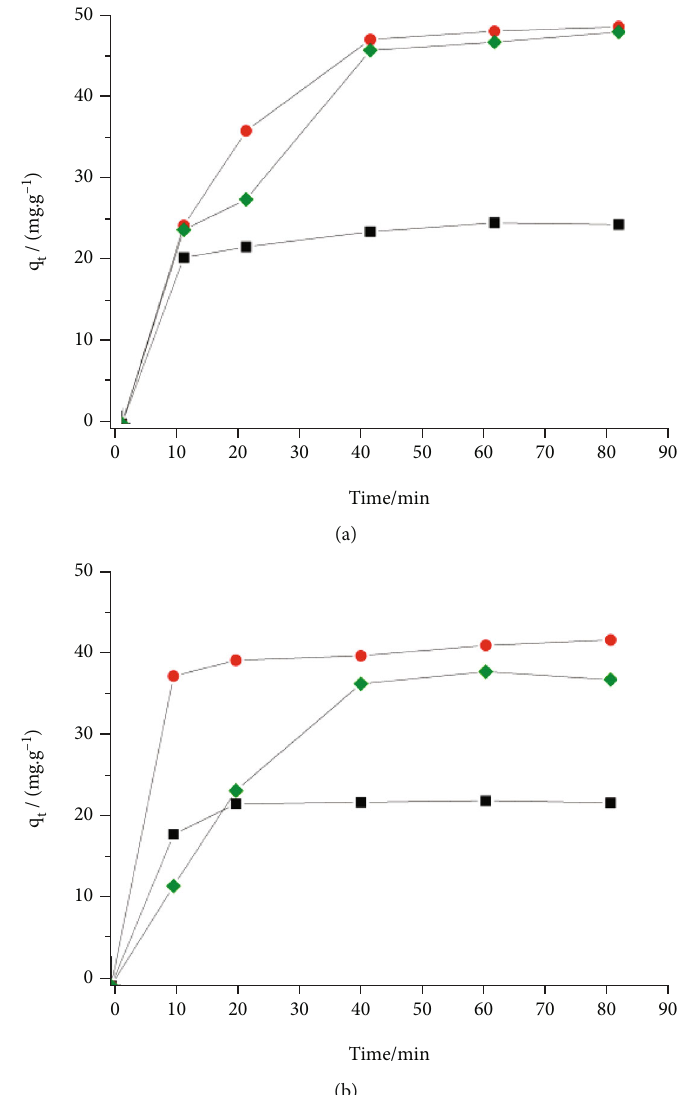
Figure 7: E ff ect of contact time and initial concentration (50 ppm (black), 100ppm (green), and 200 ppm (red)) on adsorption behavior of MB by (a) Asp-MSNs and (b) Gly-MSNs ( V =10mL, T